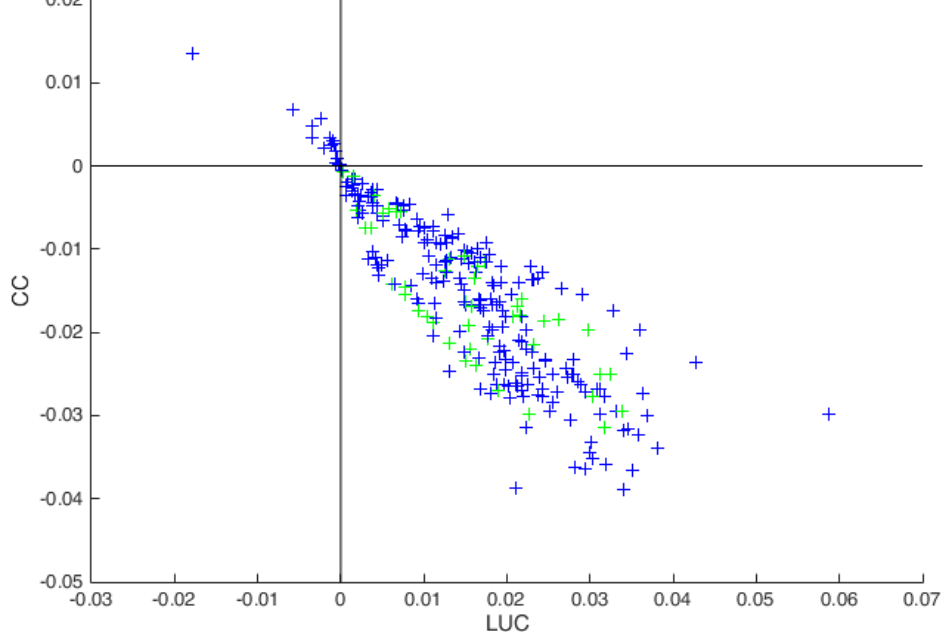
Figure 12. Differences in contribution of land use change ( x -axis) and climate change ( y -axis) between calculating with variable and constant potential evapotranspiration values for all American catchments. Green crosses indicate a Cfa climate and blue crosses indicate other climates.